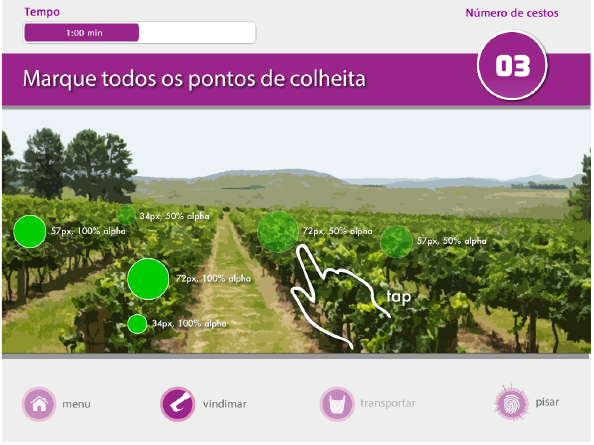
Fig. 1. Targets taping and sizing activity